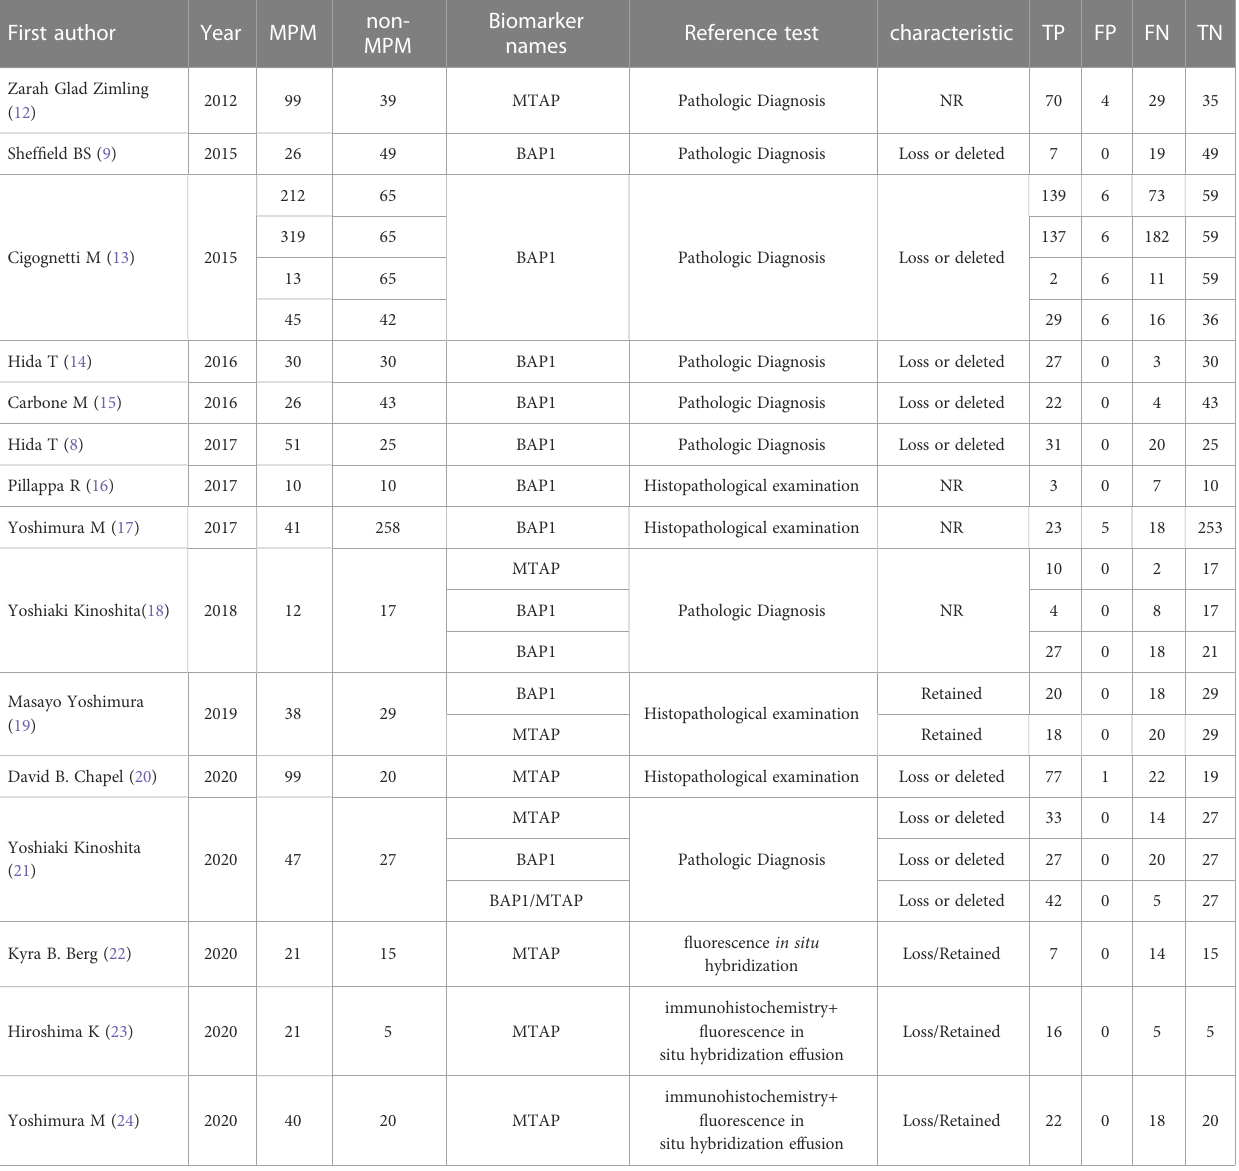
TABLE 1 Summary of included